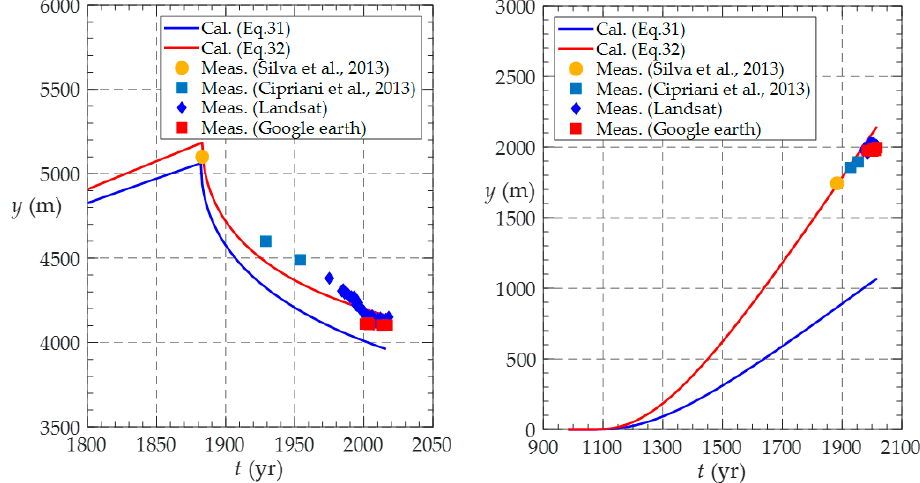
Figure 16. Validation of the calibrated parameters for the Ombrone River delta at ( left ) the river mouth and ( right ) at the boundary.